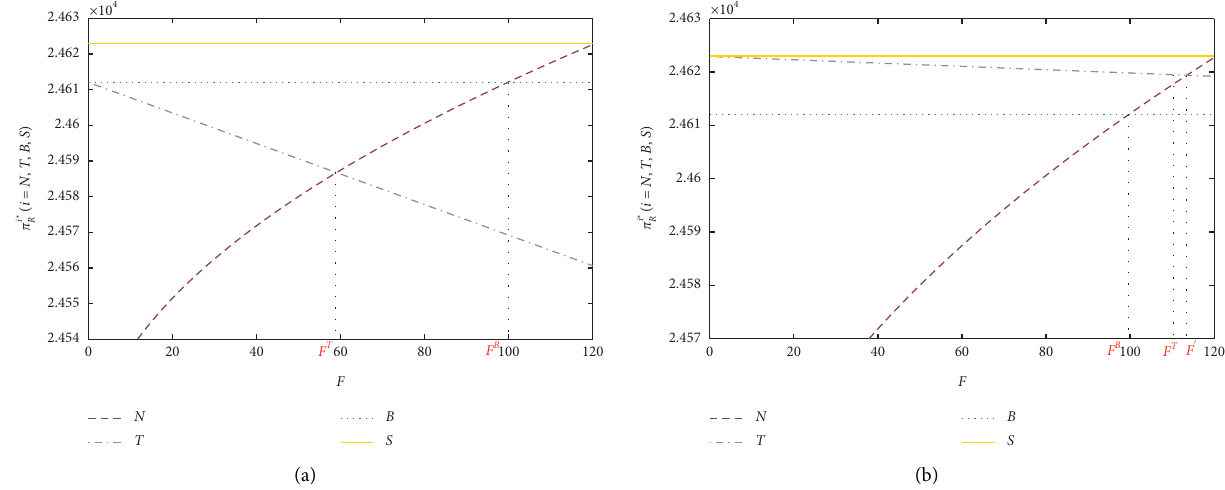
Figure 4: The influence of initial capital on the retailer’s profit. (a) θ � 0 . 3. (b) θ � 0 . 03.